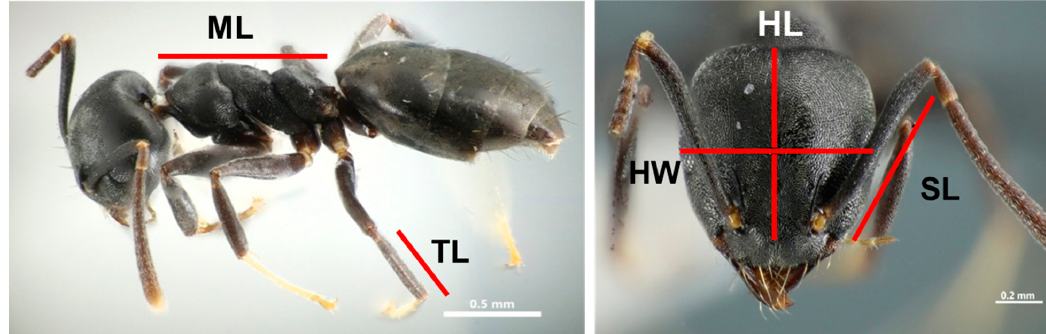
Figure 2. Five morphological characters measured for T. brunneus workers: Head Width (HW), Head Length (HL), Tibia Length (TL), Mesosoma Length (ML), and Scape Length (SL).